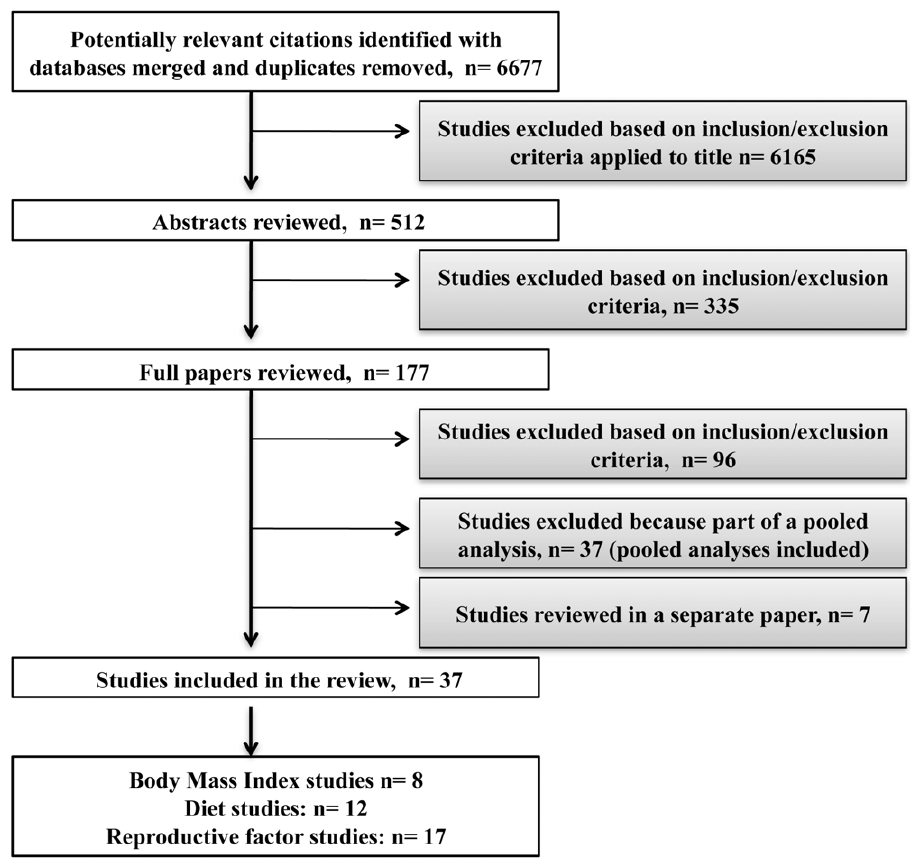
Figure 1. Study selection process. This flowchart includes the study identification process for this paper and studies on environmental risk factors for thyroid cancer that were reviewed in a separate